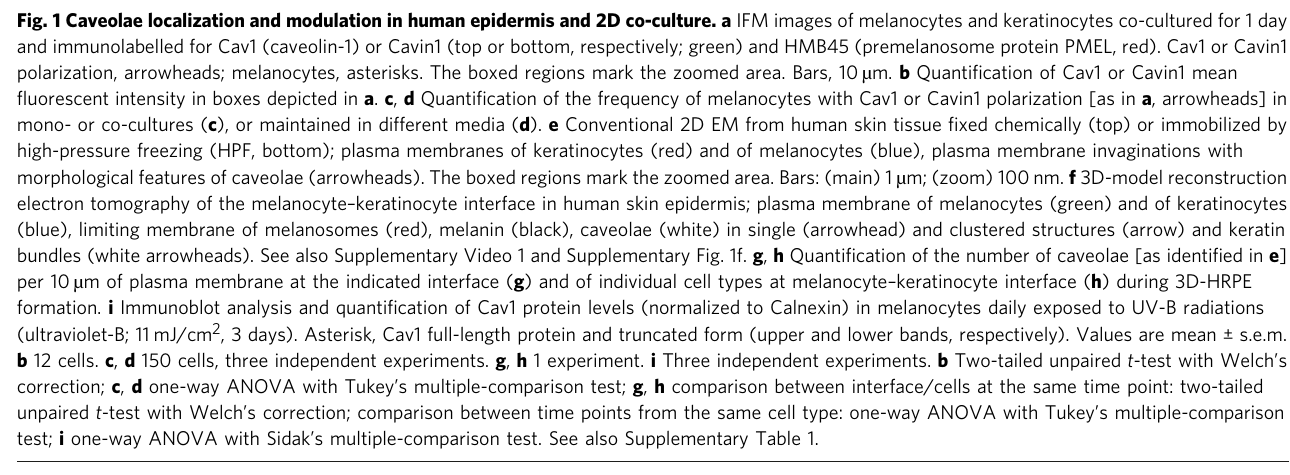
Fig. 1 Caveolae localization and modulation in human epidermis and 2D co-culture. a IFM images of melanocytes and keratinocytes co-cultured for 1 day and immunolabelled for Cav1 (caveolin-1) or Cavin1 (top or bottom, respectively; green) and HMB45 (premelanosome protein PMEL, red). Cav1 or Cavin1 polarization, arrowheads; melanocytes, asterisks. The boxed regions mark the zoomed area. Bars, 10 µ m. b Quanti fi cation of Cav1 or Cavin1 mean fl uorescent intensity in boxes depicted in a . c , d Quanti fi cation of the frequency of melanocytes with Cav1 or Cavin1 polarization [as in a , arrowheads] in mono- or co-cultures ( c ), or maintained in different media ( d ). e Conventional 2D EM from human skin tissue fi xed chemically (top) or immobilized